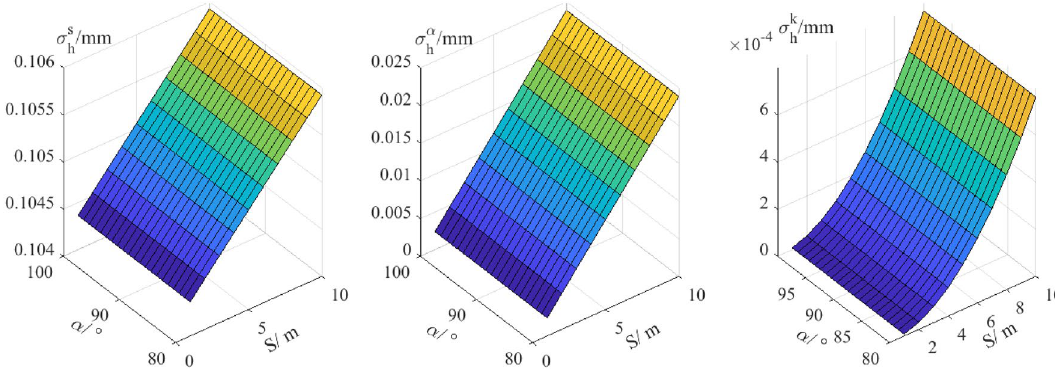
Figure 1. Errors analysis of trigonometric levelling in 10